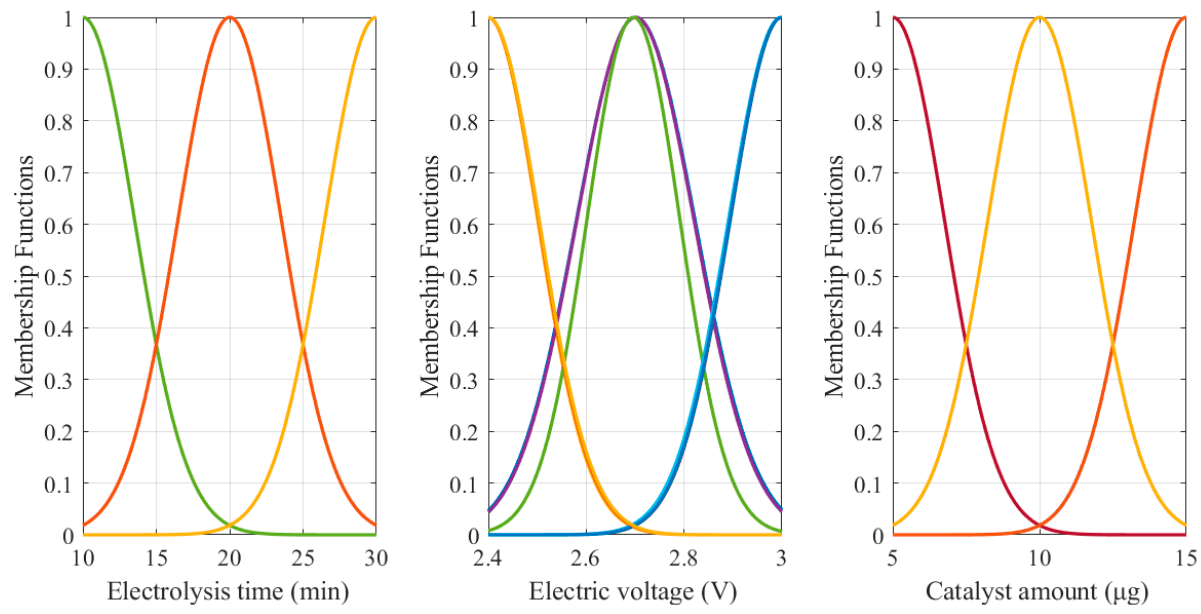
Figure 4. MFs of the inputs of the ANFIS model of the water electrocatalysis process.